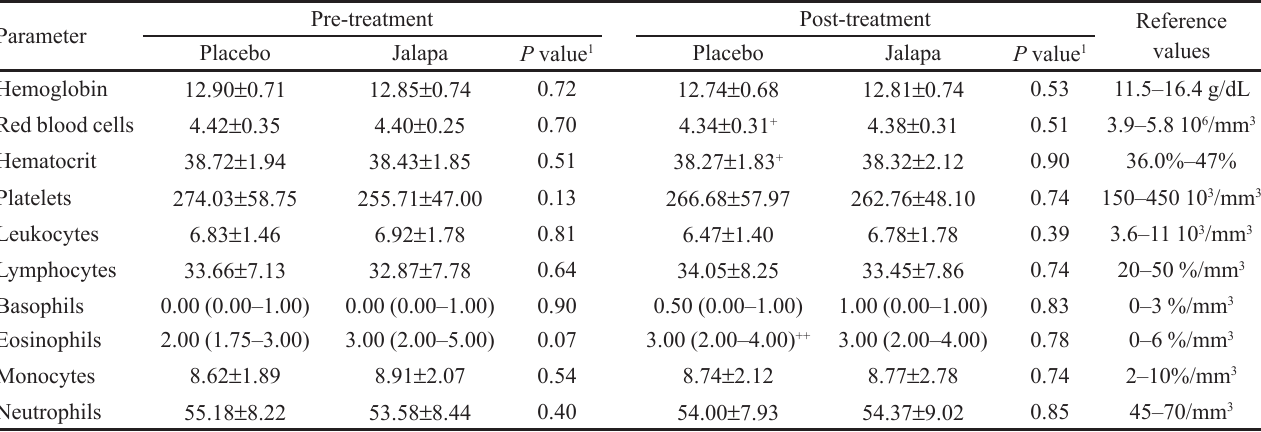
TABLE I - Hematological test results of the placebo and jalapa groups in the pre-treatment and post-treatment, expressed as mean ± standard deviation or median and interquartile range